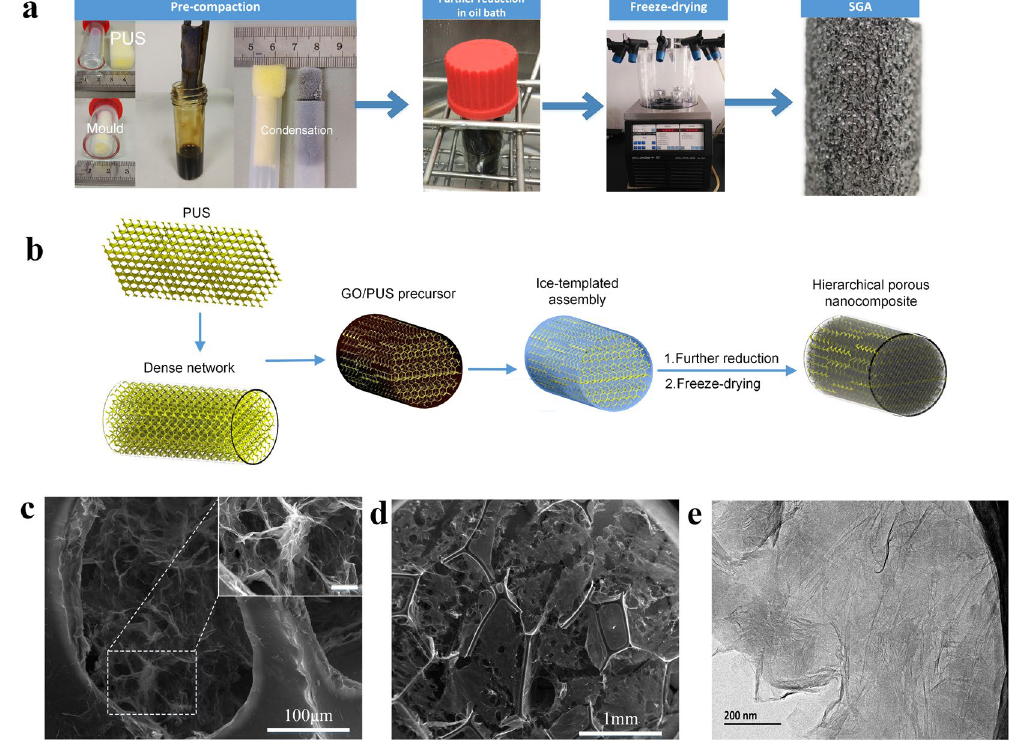
Figure 1. ( a ) Digital images of the SGA fabrication process. ( b ) A schematic representation of the different stages during the formation of the hierarchical porous structure; ( c ) SEM images of the nested porous structure (inset scale bar is 10 μ m). ( d ) Magnified image of hierarchical structure assembled from rGO/sponge from the Ice-templating method. ( e ) The transmission electron microscopy (TEM) image of